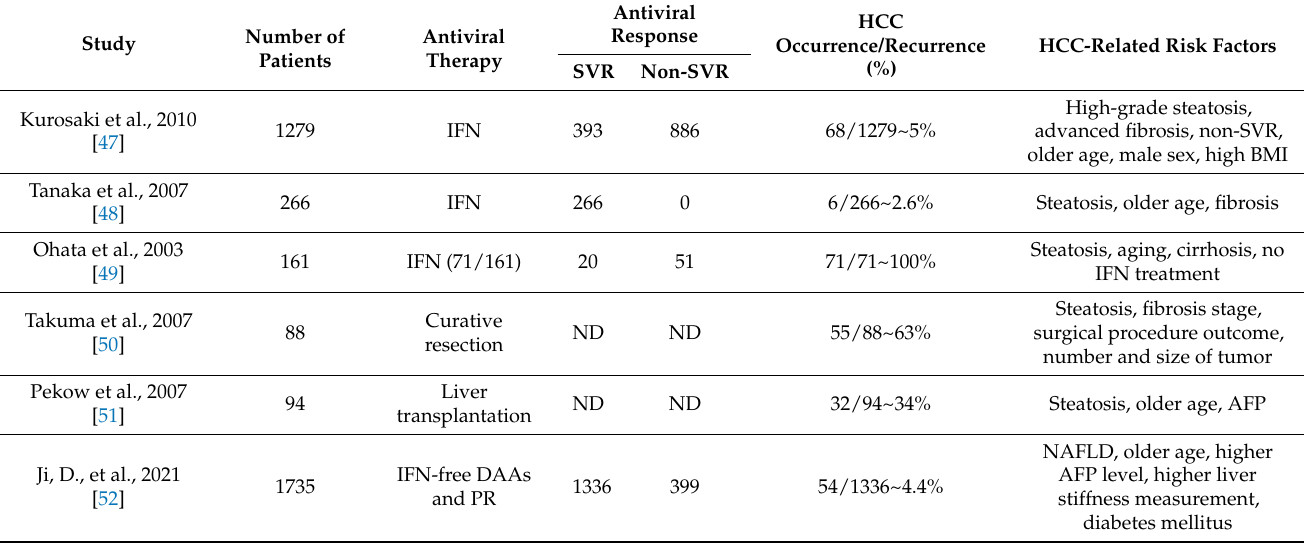
Table 1. HCV-related steatosis increases hepatocellular carcinoma risk. HCV: hepatitis C virus; IFN: interferon; HCC: hepatocellular carcinoma; SVR: sustained virologic response; BMI: body mass index; AFP: alpha-fetoprotein; DAAs: direct-acting antivirals; PR: Pegylated interferon plus ribavirin; ND: not